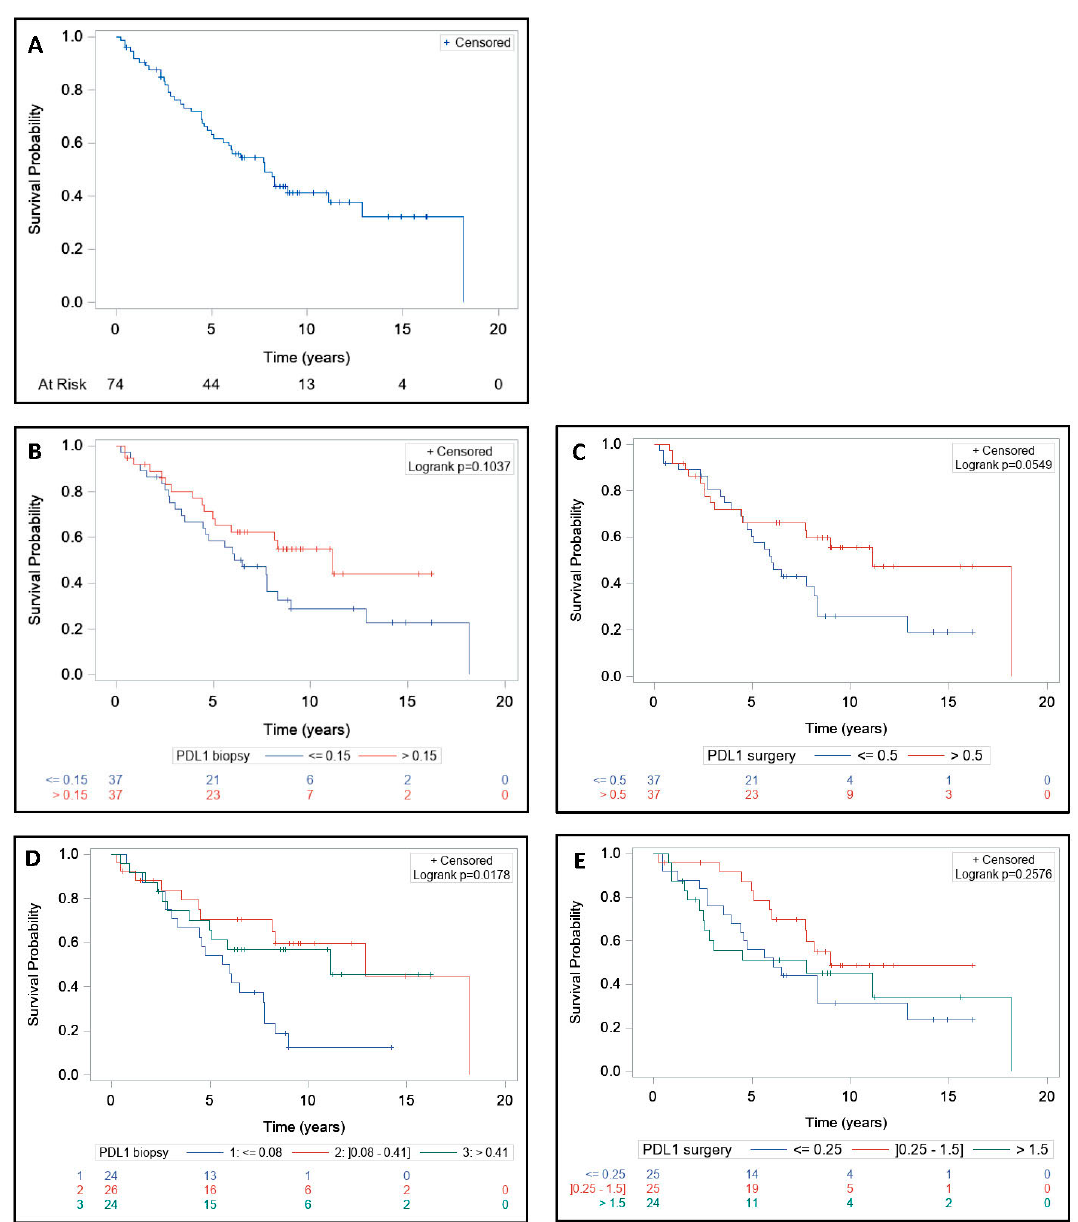
Figure 2. Impact of PD-L1 expression on overall survival before and after treatment. Patients ( n = 74) were treated with neoadjuvant short-course radiotherapy or long-course